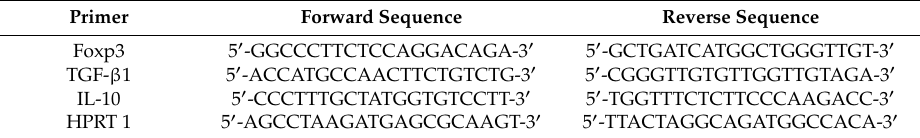
Table 1. Four pairs of specific primers used for quantitative real-time